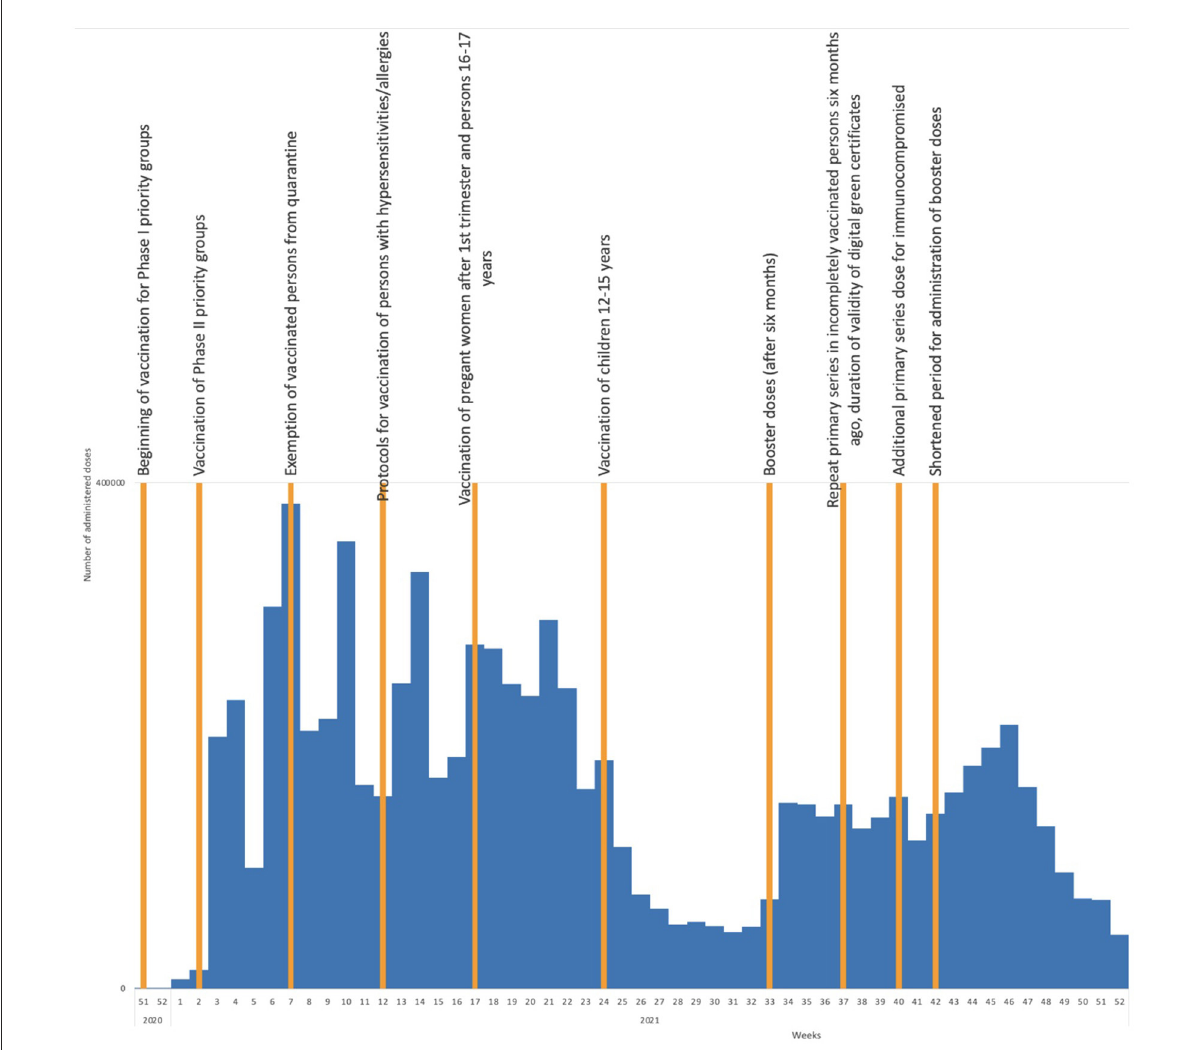
FIGURE1 COVID-19 vaccine uptake by week in 2020 and 2021 and timing of adoption of important expert committee recommendations.